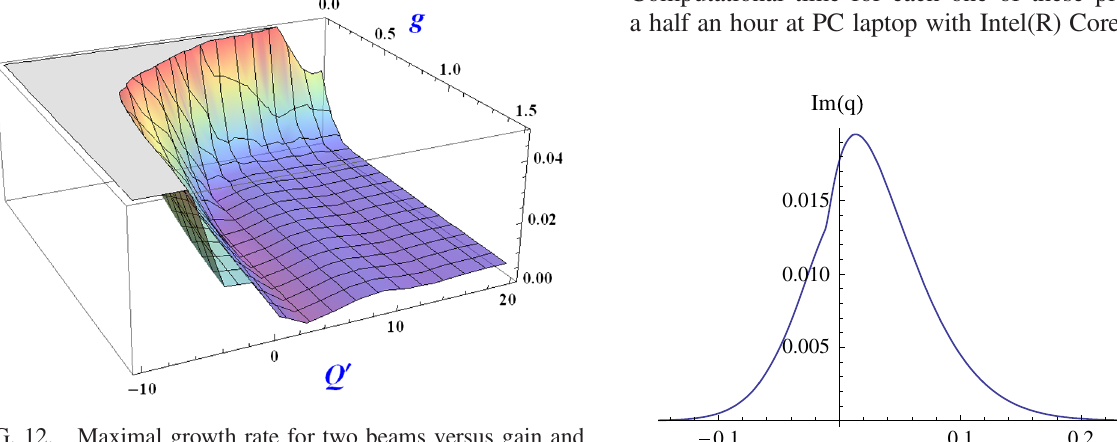
FIG. 12. Maximal growth rate for two beams versus gain and chromaticity.